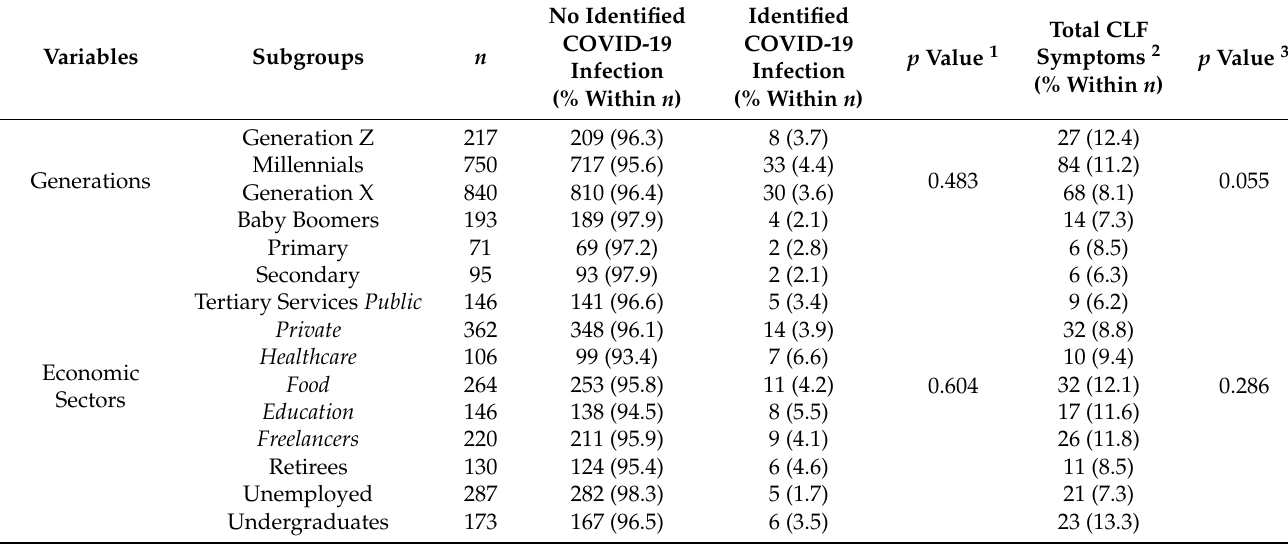
Table 4. Prevalence of COVID-19 and CLF symptoms among generations and economic sectors.